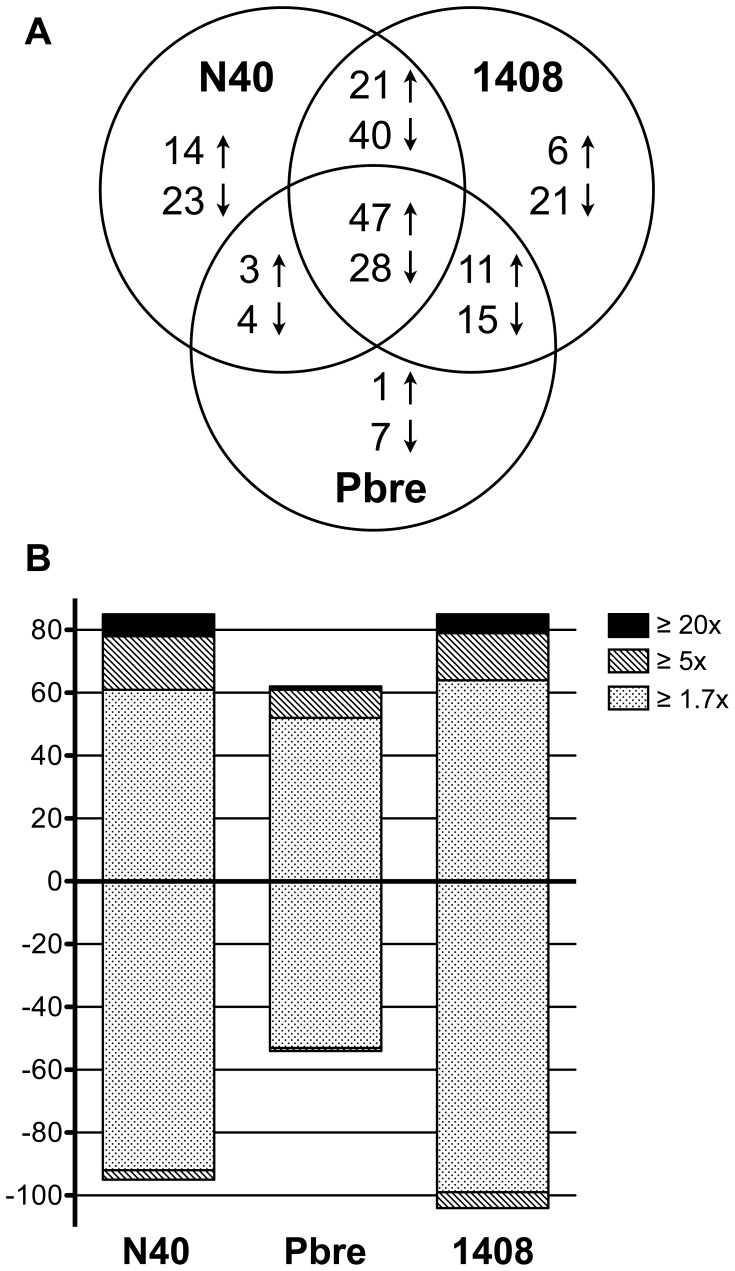
Gene expression profiles obtained from dermal fibroblasts stimulated with different strains of B. burgdorferi ss.(A) Venn diagram of genes significantly up-regulated (↑) or down-regulated (↓) after fibroblast stimulation with Borrelia, and compared with unstimulated fibroblasts. (B) Number of genes differentially expressed during fibroblast stimulation with Borrelia. The bars reflect the number of up-regulated genes (+) and down-regulated genes (-) for each strain. The light dotted areas correspond to gene expression changes of 1.7–5.0-fold, the grey hatched areas correspond to changes of 5.0–20.0-fold and black areas to changes ≥20.0-fold.